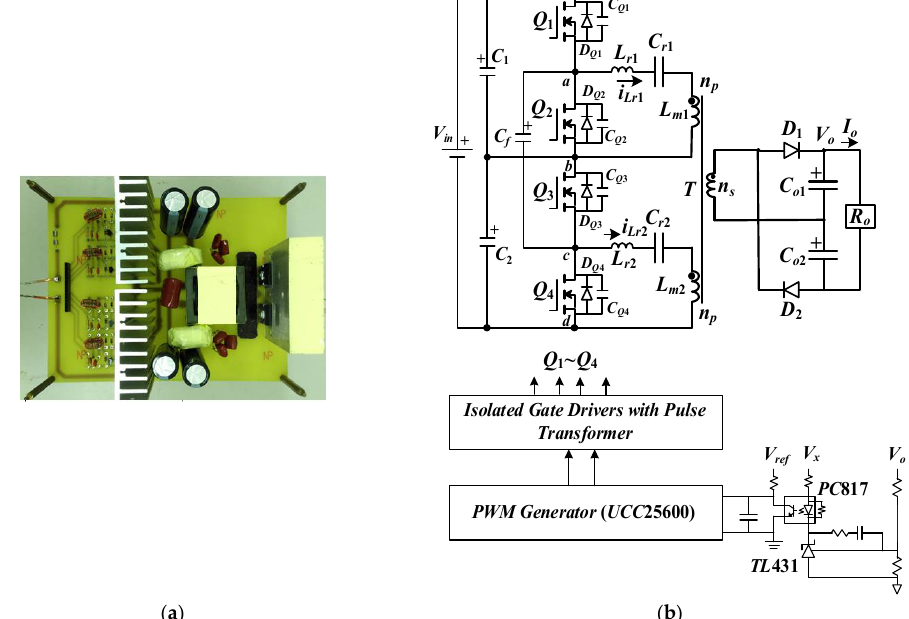
Figure 7. Proposed prototype circuit ( a ) photograph and ( b ) block diagram.